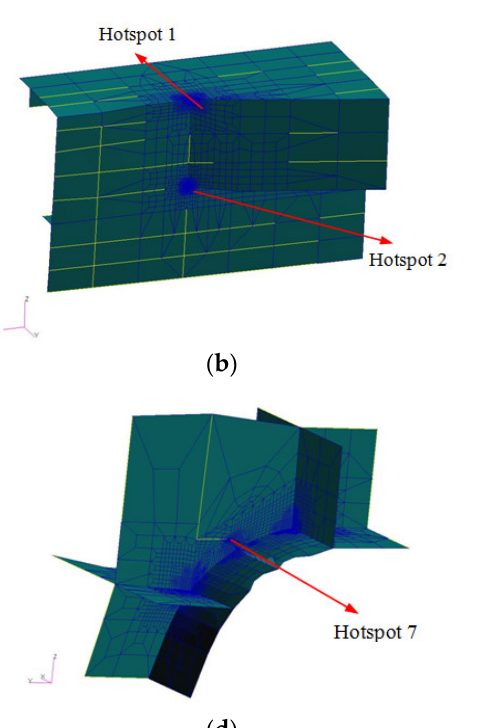
Figure 1. ( a ) The whole finite element (FE) model and details ( b ) Detail 1, ( c ) Detail 2, and ( d ) Detail 3.